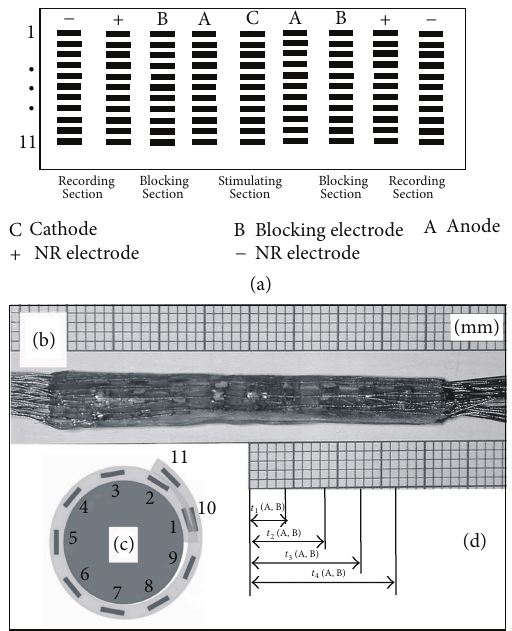
Figure 1: (a) Matrix of ninety-nine electrodes, (b) fabricated cuff, (c) cross-section through the cuff, and (d) distances between spiral groups of electrodes and times used in calculations of the CV in the A- and B-fibres.